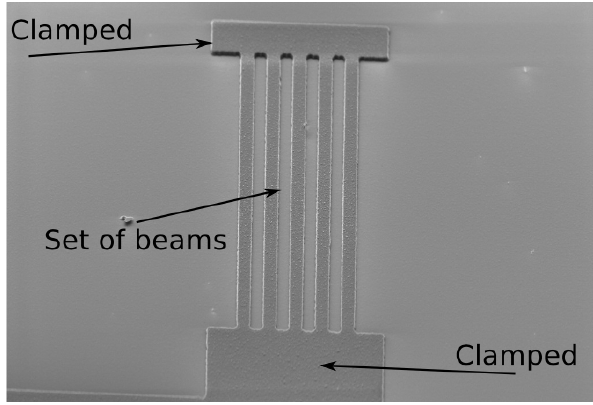
Figure 7. SEM image that shows a set of doubly clamped beams after the wet-etching process. After performing this step, the sample was rinsed with DI water and dried by N 2 .